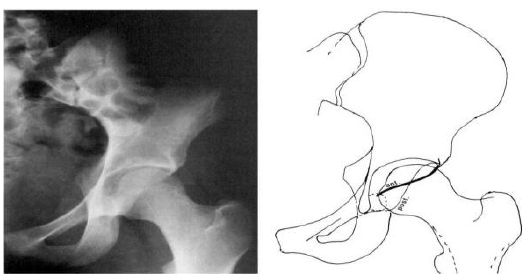
Figure 3: A. Diagram showing acetabular retroversion and the 'cross-over' sign ..(2) The diagnosis of acetabular retroversion is more difficult by plain pelvic radiograph.